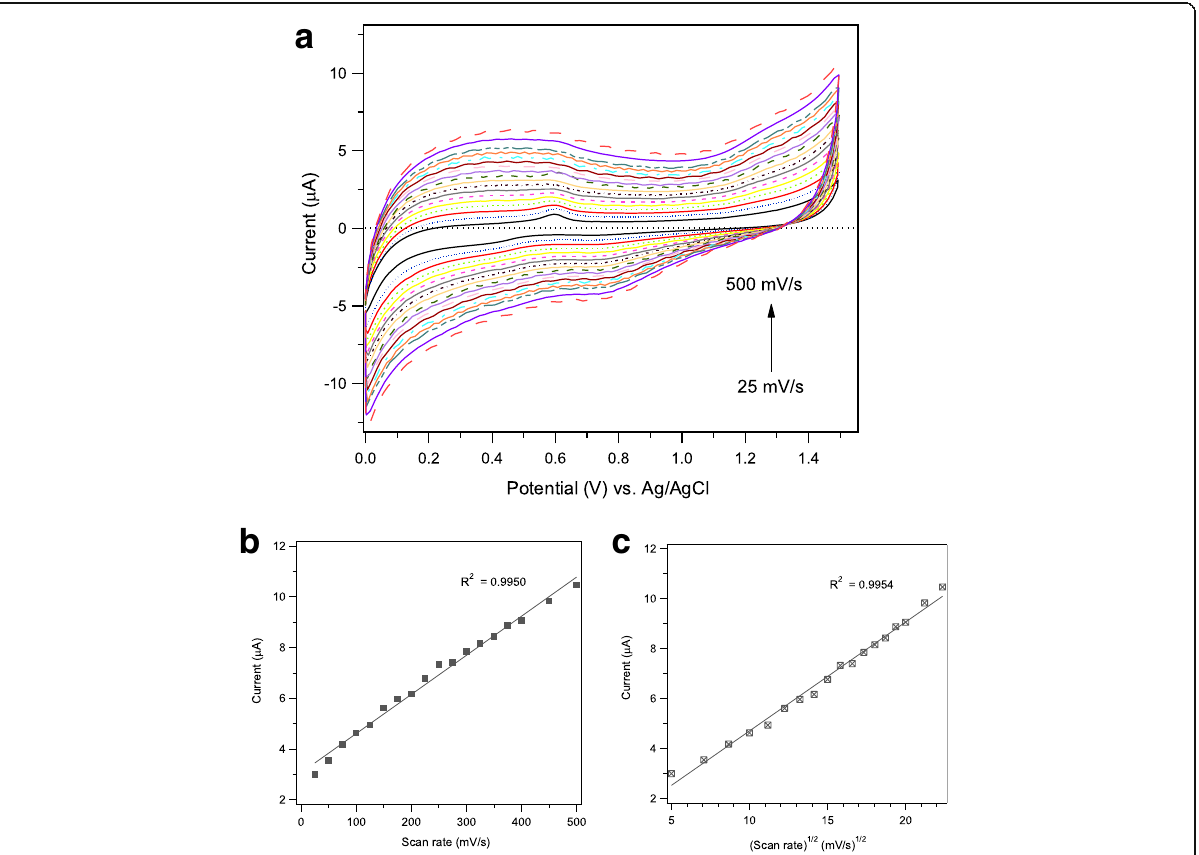
Fig. 10 a Cyclic voltammograms of mesoporous 1wt.%Ag/Fe 2 O 3 -modified GCE measured in 0.1 M PBS solution (pH = 7) containing 0.2 mM ethanol at various scan rates of 25, 50, 75, 100, 125, 150, 175, 200, 225, 250, 275, 300, 325, 350, 375, 400, 450, and 500 mV/s. Plot of anodic peak current versus scan rate ( b ) and versus square root of scan rate ( c